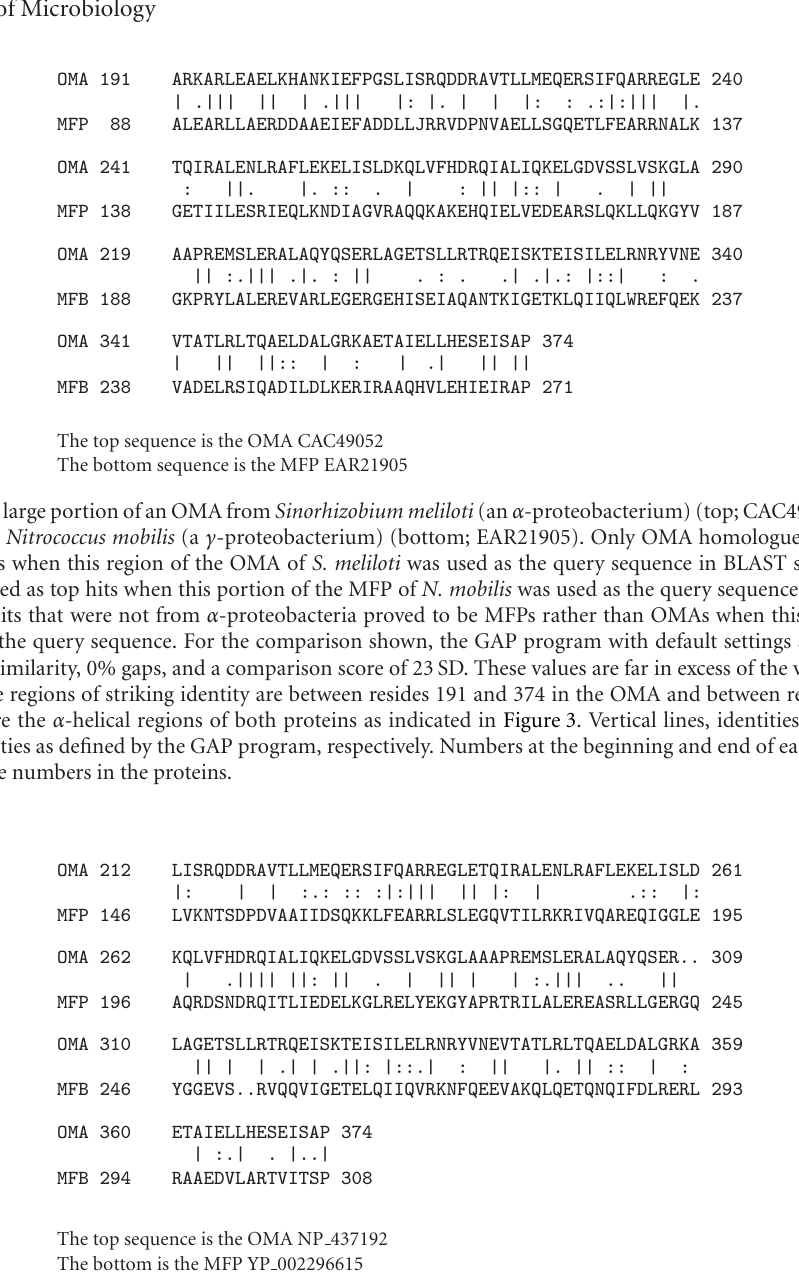
Figure 2: A second alignment, comparable to that shown in Figure 1 using two di ff erent proteins that showed similar degrees of similarity throughout the lengths of their α -helical regions. The OMA homologue was from Sinorhizobium meliloti (top; NP 437192) while the MPF was from another α -proteobacterium, Rhodospirillum centenum (bottom; YP 002296615). The alignment and comparison scores were determined as for Figure 1 giving 32% identity, 45% similarity, 2 gaps, and a comparison score of 23 S.D.